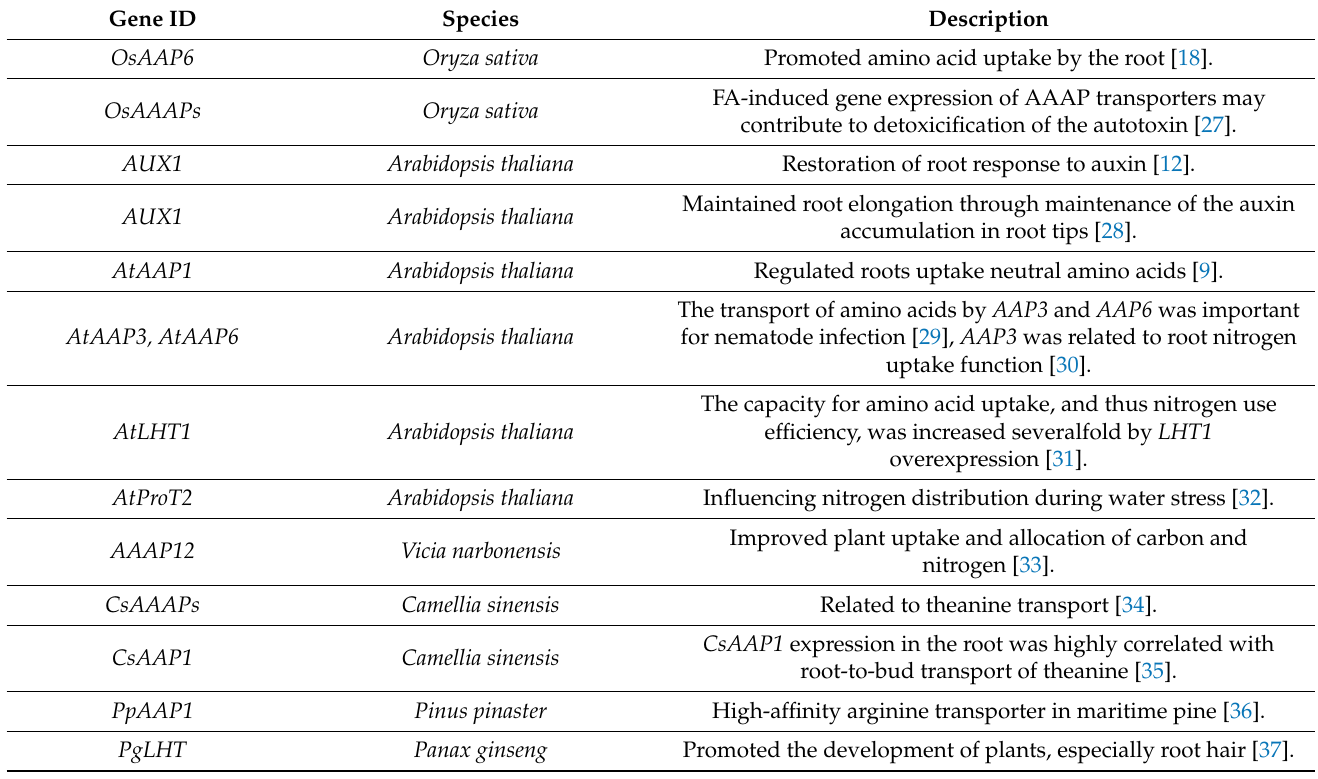
Table 1. PtrAAAPs regulate root